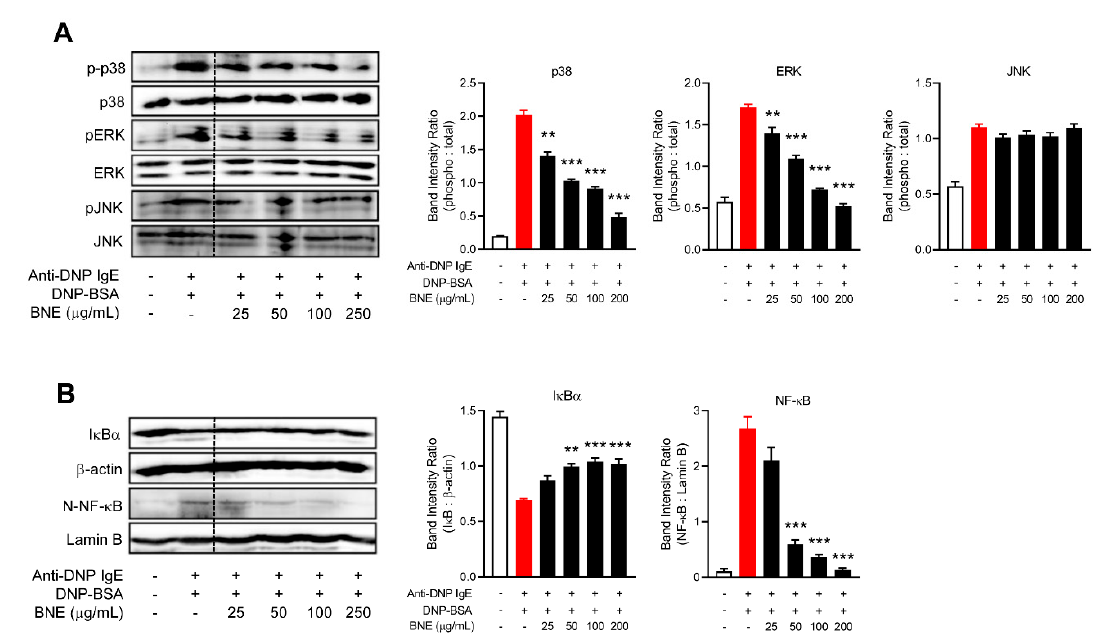
Figure 3. BNE inhibited MAPKs and the nuclear factor- κ B (NF- κ B) signaling pathway. ( A , B ) RBL-2H3 cells were pre-sensitized with anti-DNP IgE (1 × 10 6 cells / well). Cells were pre-sensitized with anti-DNP IgE (100 ng / mL) overnight. The cells were treated with or without indicated doses of DNE for 1 h and then challenged with anti-DNP-BSA for 15 min in RBL-2H3. Whole cell lysates or nuclear extracts were analyzed by western blotting: MAPKs (p38, ERK, and JNK) ( A ) and NF- κ B ( B ) pathways. Protein levels were normalized to total form or β -actin and quantified using Image-J software (right panel). Data represent the means ± SEM from three independent experiments. ** p < 0.01; *** p < 0.001, Tukey’s test, di ff erent from the Anti-DNP IgE plus DNP-BSA-treated group. Anti-DNP IgE, anti-dinitrophenyl immunoglobulin E; DNP-BSA, dinitrophenyl-Bovine serum albumin; BNE, Boehmeria nivea extract; MAPKs, mitogen-activated protein kinase; NF- κ B, nuclear factor- κ B; I κ B, I kappa-B alpha.